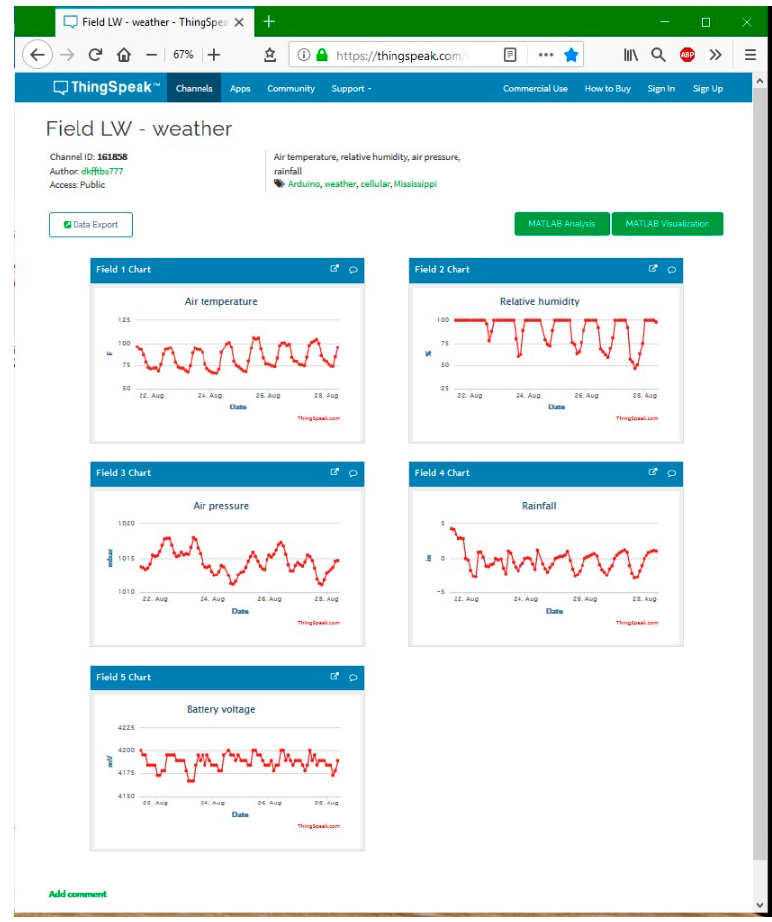
Figure 7. Sample of gateway weather data uploaded to a ThingSpeak webpage.